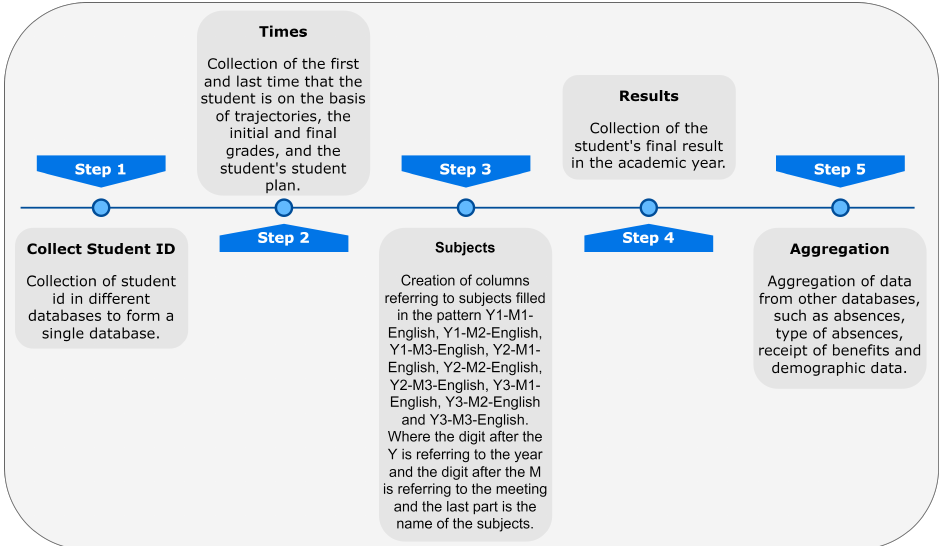
Figure 3. Database